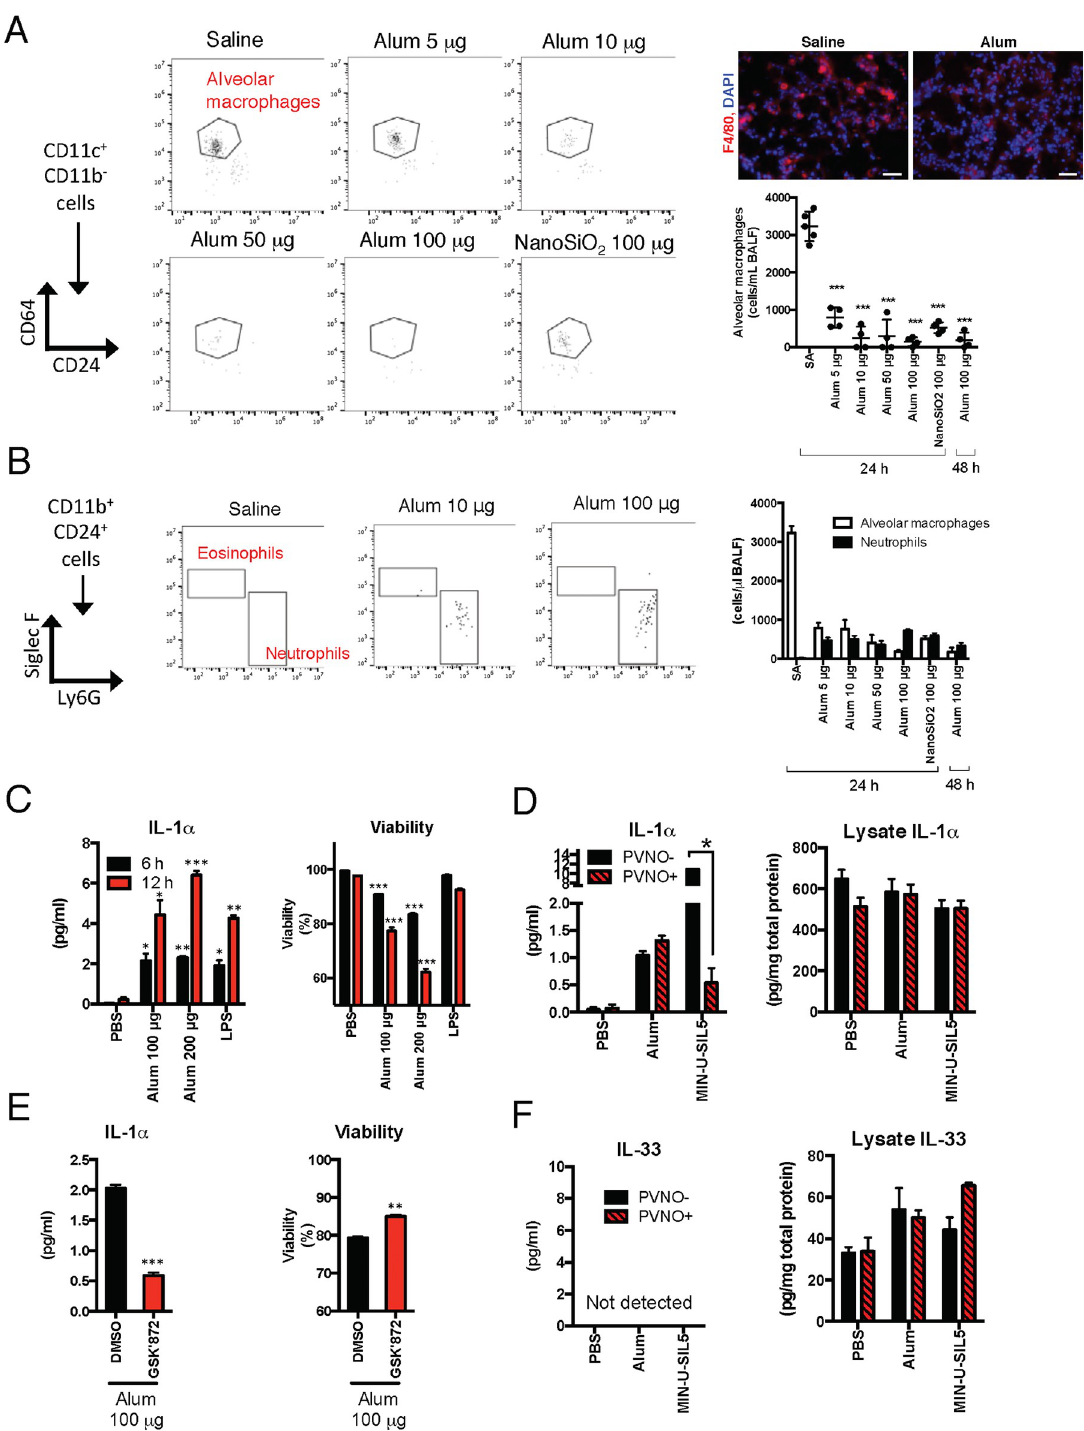
Fig 2. Alum induces necroptosis in freshly isolated alveolar macrophages accompanied by IL-1 α secretion but not IL-33. ( A ) Mice were intranasally administered SA or 5, 10, 50, or 100 μ g of alum or 100 μ g of NanoSiO 2 . At 24 h or 48 h after administration, the mice were euthanized, and the lungs were collected for FACS analyses. Alveolar macrophages in the lung were gated as live (propidium iodide negative) CD11c + CD11b + CD64 + CD24 + . The alveolar macrophage number per mL of BALF was calculated. Freshly frozen sections of lung tissue were prepared at 24 h after intranasal administration of SA or alum and stained with anti-F4/80 Abs and DAPI. (B) Neutrophils and eosinophils in the lung were gated as live CD11b + CD24 + Ly6G + SiglecF - and CD11b + CD24 + Ly6G - SiglecF + cells,